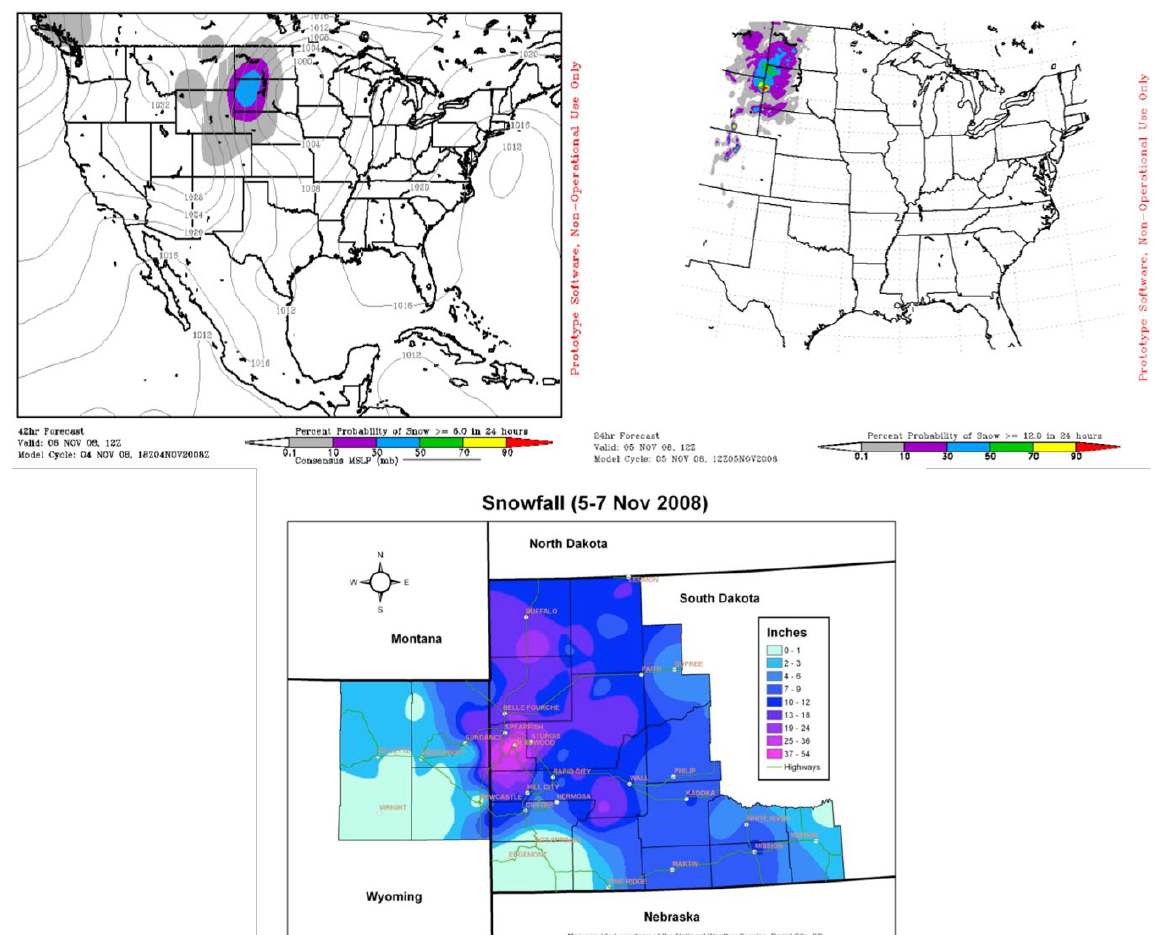
Figure 2. Rank histogram of 48 hour ensemble wind speed forecasts from multi-physics WRF- based ensemble systems using GEFS ICs with no data assimilation (NoDA), model parameter per- turbations (MP), and Ensemble Transform Kalman Filter (ETKF) data assimilation. DGFS used GEFS ICs but with the same WRF configuration for all members, serving as a baseline for compari- son.